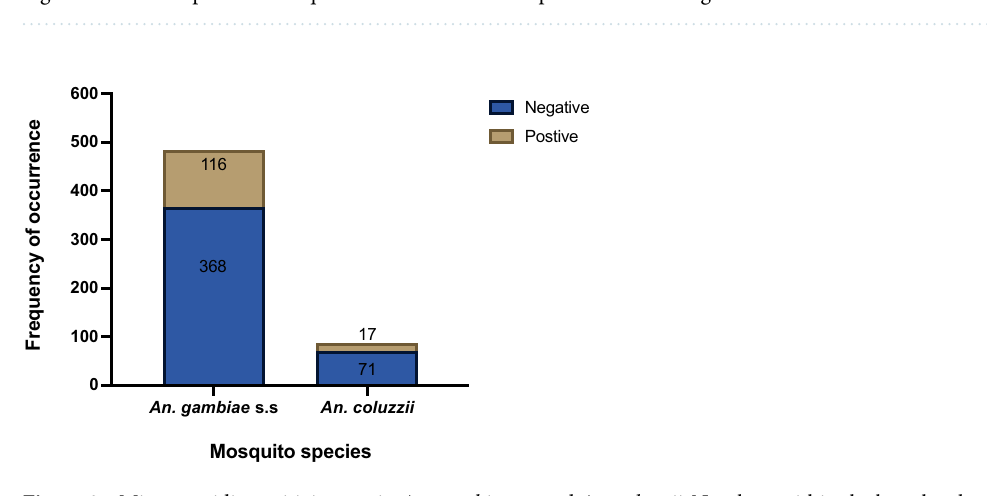
Figure 1. Map of Ghana showing study sites where mosquitoes were collected. Only the regions (6 out of 16) where the study sites are located are named in upper cases. Study sites are named in bold. Red stars depict regions where MB -positive mosquitoes were recorded. Map was created using ArcGIS v10.4.1.